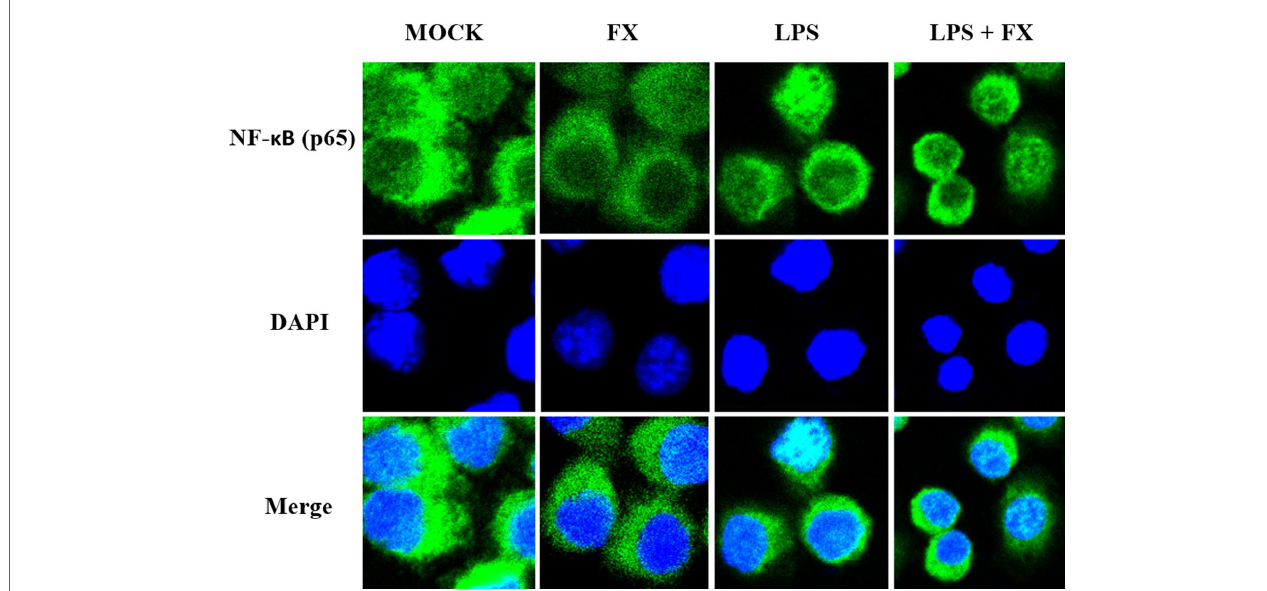
FIGURE 8 | The effects of fucoxanthin (FX) on NF- κ B nuclear translocation in RAW264.7 cell treated with LPS stimulus (scale bars: 20 μm). Immunofluorescence staining of NF- κ B (p65) in RAW264.7 cell treated FX (10 nmol/L) at 3 h followed by LPS (1.0 mg/L) for stimulation. Immunofluorescence showed that FX inhibited NF- κ B nuclear translocation upon LPS stimulation.